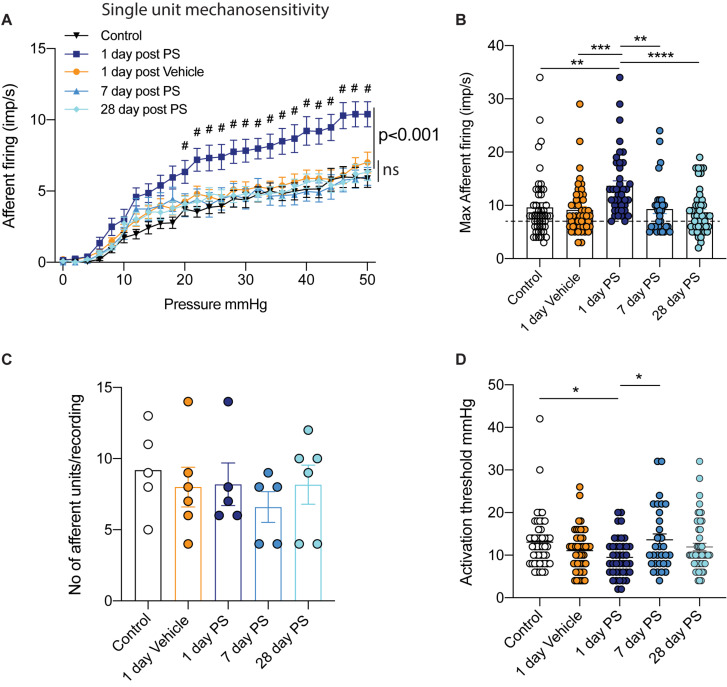
Single unit bladder afferent mechanosensitivity. (A) One day after in vivo infusion of protamine sulfate (PS), but not vehicle, single bladder afferent units exhibit hypersensitivity to bladder distension (n = 41–48 individual units from N = 5–6 mice, #P < 0.05, Two-way ANOVA with Tukey’s multiple comparisons post hoc test). Single unit bladder afferent mechanosensitivity is unchanged at seven days post PS infusion and is maintained at control levels 28 days after PS infusion (n = 31–49 individual units N = 5–6 mice, ns
P > 0.05, Two-way ANOVA with Tukey’s multiple comparisons post hoc test). (B) Peak single unit afferent responses to bladder distension (0–50 mmHg) are significantly elevated one day after PS infusion compared to control, One day post vehicle, and seven and 28 days post PS (n = 31–49 individual units from N = 5–6 mice, **P < 0.01,***P < 0.05, one-way ANOVA with Tukey’s multiple comparisons post hoc test). Peak firing of each individual unit is * represented by a single dot. Dashed line represents least responsive units in 1-day PS group. (C) The mean number of single units differentiated by spike sorting software in each individual multiunit nerve recording experiment (N = 5–6 mice). (D) The activation threshold of individual afferent units is significantly reduced one day after in vivo PS but not vehicle infusion (n = 31–49 individual units from N = 5–6 mice, *P < 0.05, one-way ANOVA with Tukey’s multiple comparisons post hoc test).